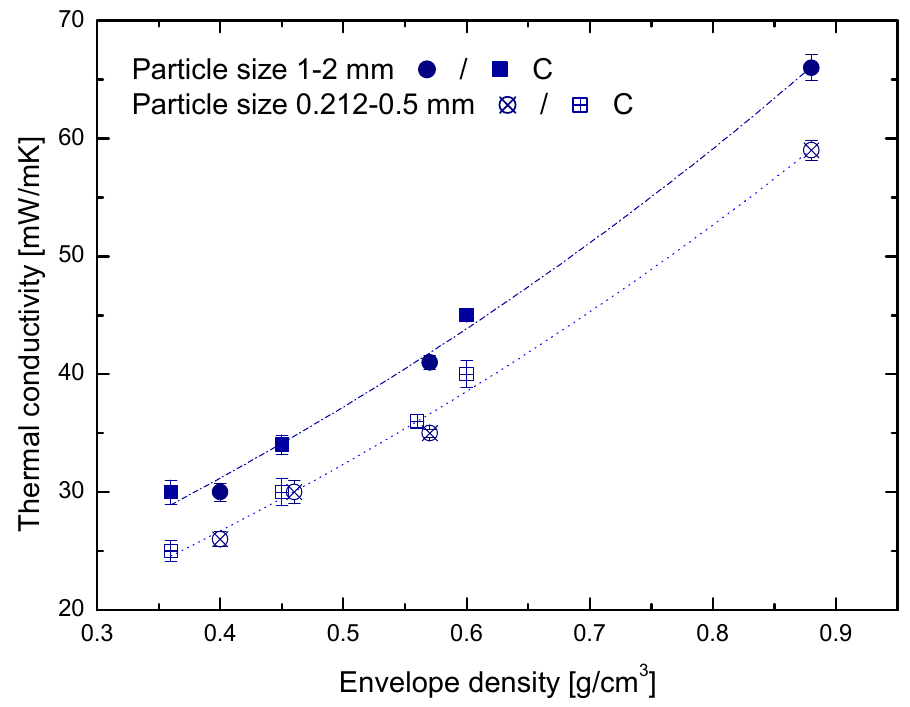
Figure 4. Thermal conductivity of hybrid xerogels versus envelope density measured at two different particle sizes (numerical values can be found in the Supplementary Materials, Table S3).